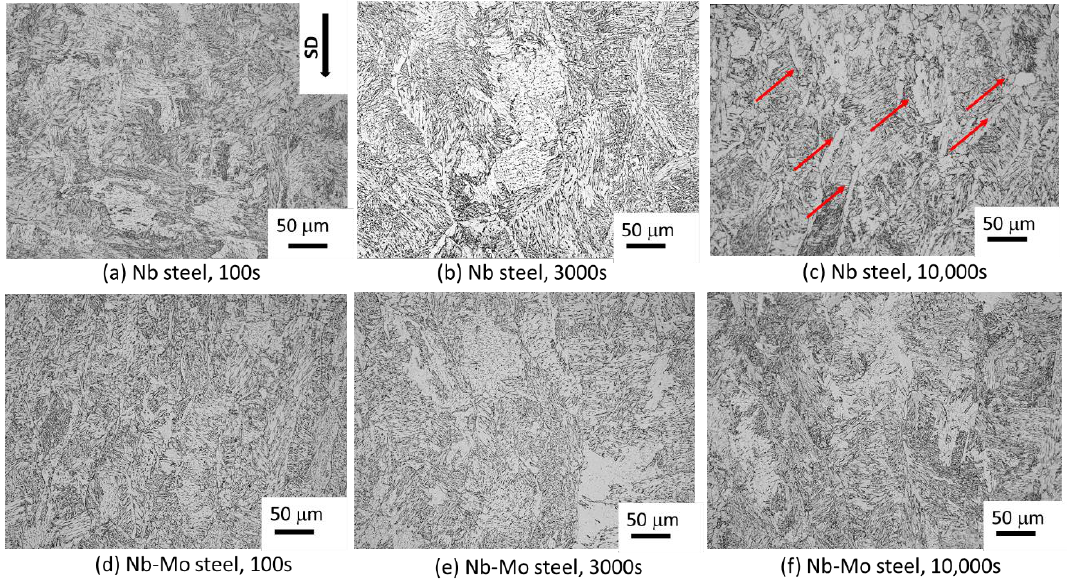
Figure 3. Optical images of the microstructure of the Nb ( a – c ) and Nb-Mo ( d – f ) steels after isothermal holding for 100, 3000, and 10,000 s at 900 °C. (Solidification direction (SD) is shown by the black arrow in ( a ), and allotriomorphic ferrite is shown by the red arrows in ( c )).